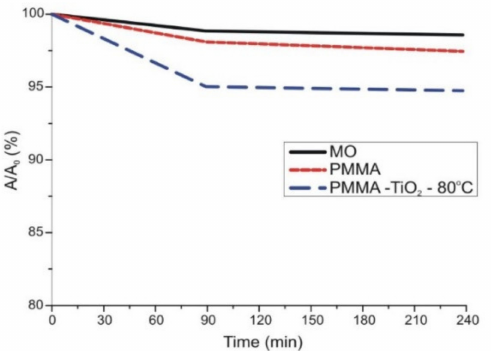
Figure 10. Photocatalytic efficiency of the amorphous TiO 2 . After 90 min, the methylene orange dye degraded 5% under UV-A illumination [adapted from [59], this work by Orsolya K é ri is licensed under a Creative Commons Attribution (CC BY 4.0)].